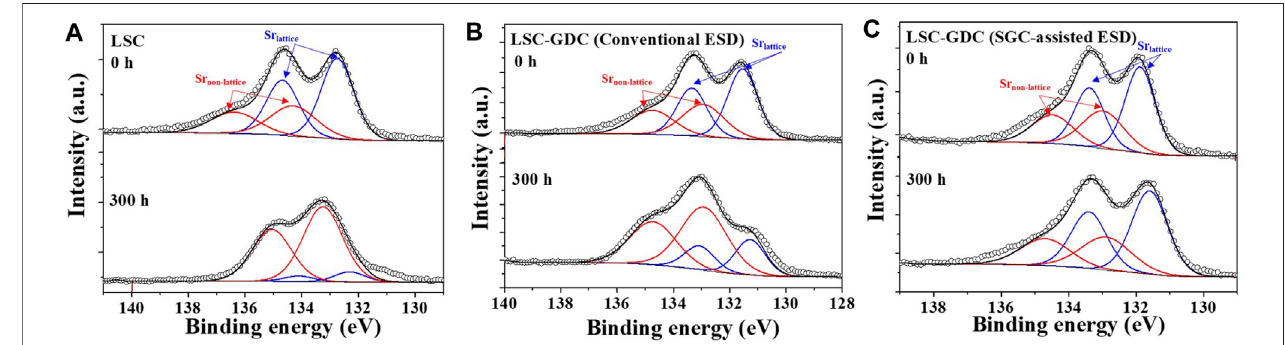
FIGURE 7 | Electrochemical performance of single cells with (A) LSC electrode and (B) LSC-GDC electrode fabricated by SGC-assisted ESD. (C) Comparison of the peak power densities in a temperature range from 500 to 650 ° C. (D) Stability test with a constant current density of 1 A/cm 2 at 600 ° C for 100 h.